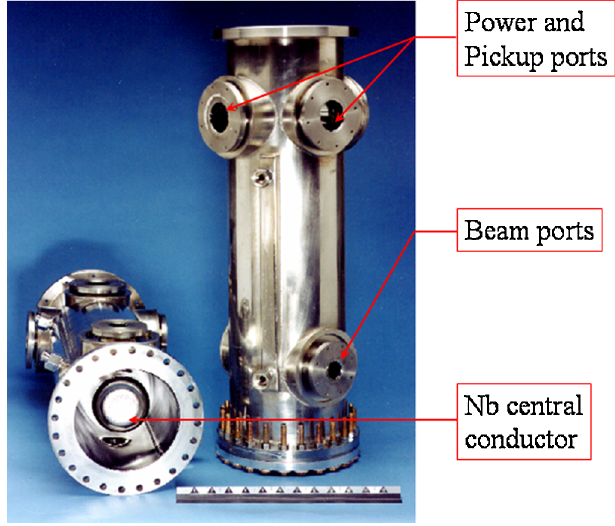
FIG. 3. (Color) Two complete quarter wave resonators with the SS